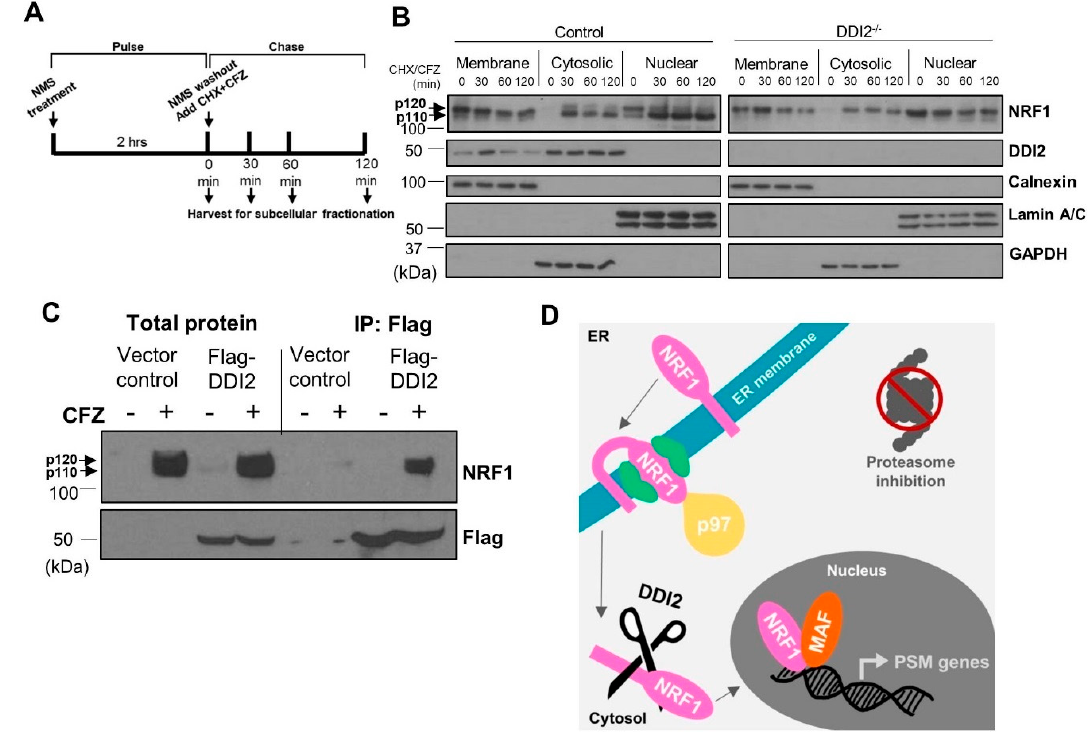
Figure 2. DDI2-mediated proteolytic processing of NRF1 occurs in the cytosol. ( A ) Schematic representation of the pulse-chase assay is shown. ( B ) NIH-3T3 control (wild-type) and DDI2 − / − cells were pulsed with 10 μ M NMS-873 (p97 inhibitor) for 2 h, then chased with 50 μ g/mL cycloheximide (CHX) and CFZ (5 μ M) for 0, 30, 60, or 120 min. Subcellular fractionation of membrane-bound, cytosolic, and nuclear proteins was analyzed by western blot using the antibodies indicated. Calnexin, Lamin A/C, and GAPDH are fractionation controls for membrane-bound, nuclear, and cytosolic proteins, respectively. Blots shown are representative of three independent experiments. ( C ) MDA-MB-231 cells stably expressing Flag-DDI2 or a vector control were treated with 200 nM carfilzomib (CFZ) or equal volume DMSO for 4 h. The lysates derived from these cells were then subjected to immunoprecipitation with anti-Flag affinity gel. Input and immunoprecipitated proteins were probed for by western blot using the indicated antibodies. Blots shown are representative of three independent experiments. ( D ) A proposed model of NRF1 activation by DDI2 is shown. When the proteasome is inhibited, NRF1 is extracted out of the ER membrane via the action of ATPase p97 into the cytosol. NRF1 is then cleaved by DDI2 before it translocates into the nucleus as an active transcription factor.